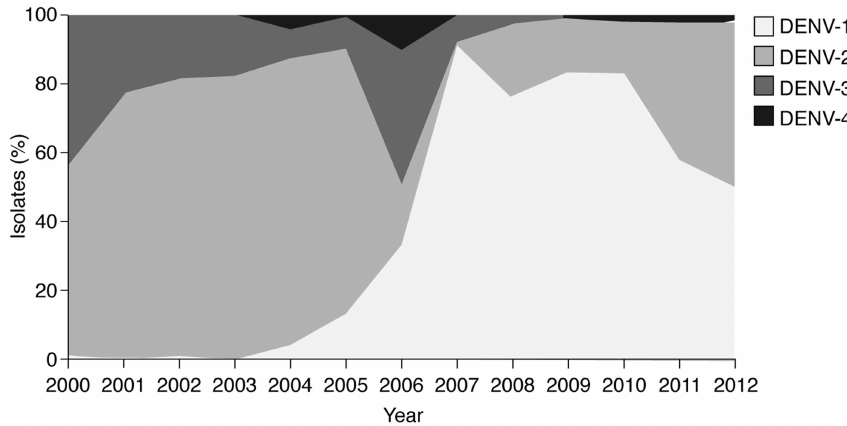
Figure 4. Circulation of dengue virus serotypes in Mexico, 2000–2011 [16,20,26] . Data shown are number cases (incidence per 100,000 population). All four DENV serotypes were in circulation during the review period, although the predominant serotype varied between years: at the beginning of the review period, DENV-2 was the predominant serotype (2000–2005). DENV-1 became predominant in 2006–2010, after which DENV-1 and -2 isolates were present in similar proportions. DENV-3 isolates were more common before 2007. DENV-4 isolates were present at low levels in most years after 2003.